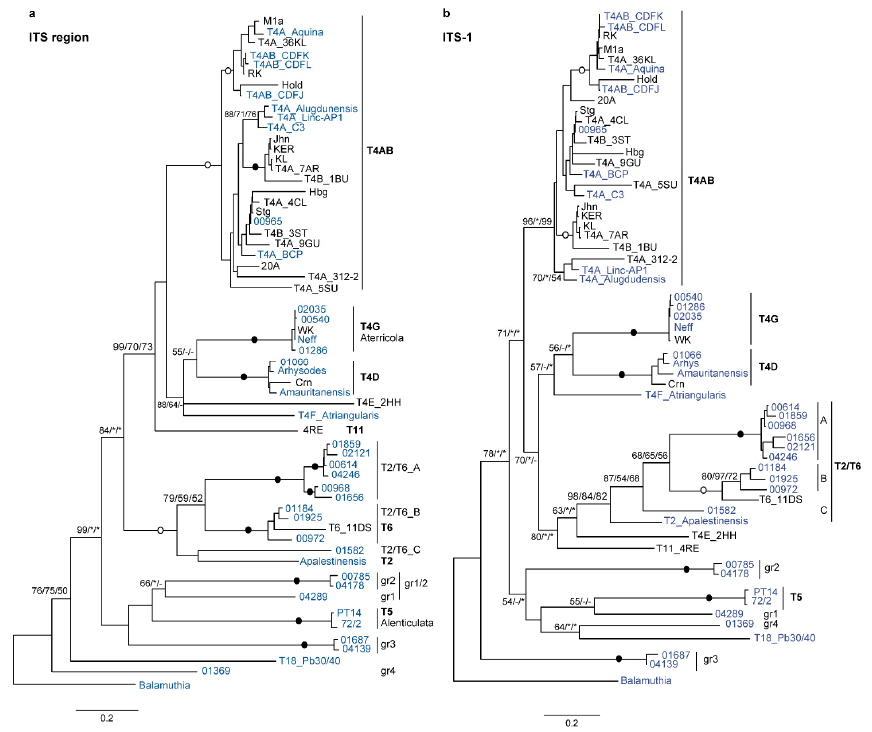
Figure 3. ITS phylogeny: ( a ) molecular phylogeny based on the entire ITS region; ( b ) molecular phylogeny based only on the ITS-1 sequence. The strains for which the entire ITS region is available